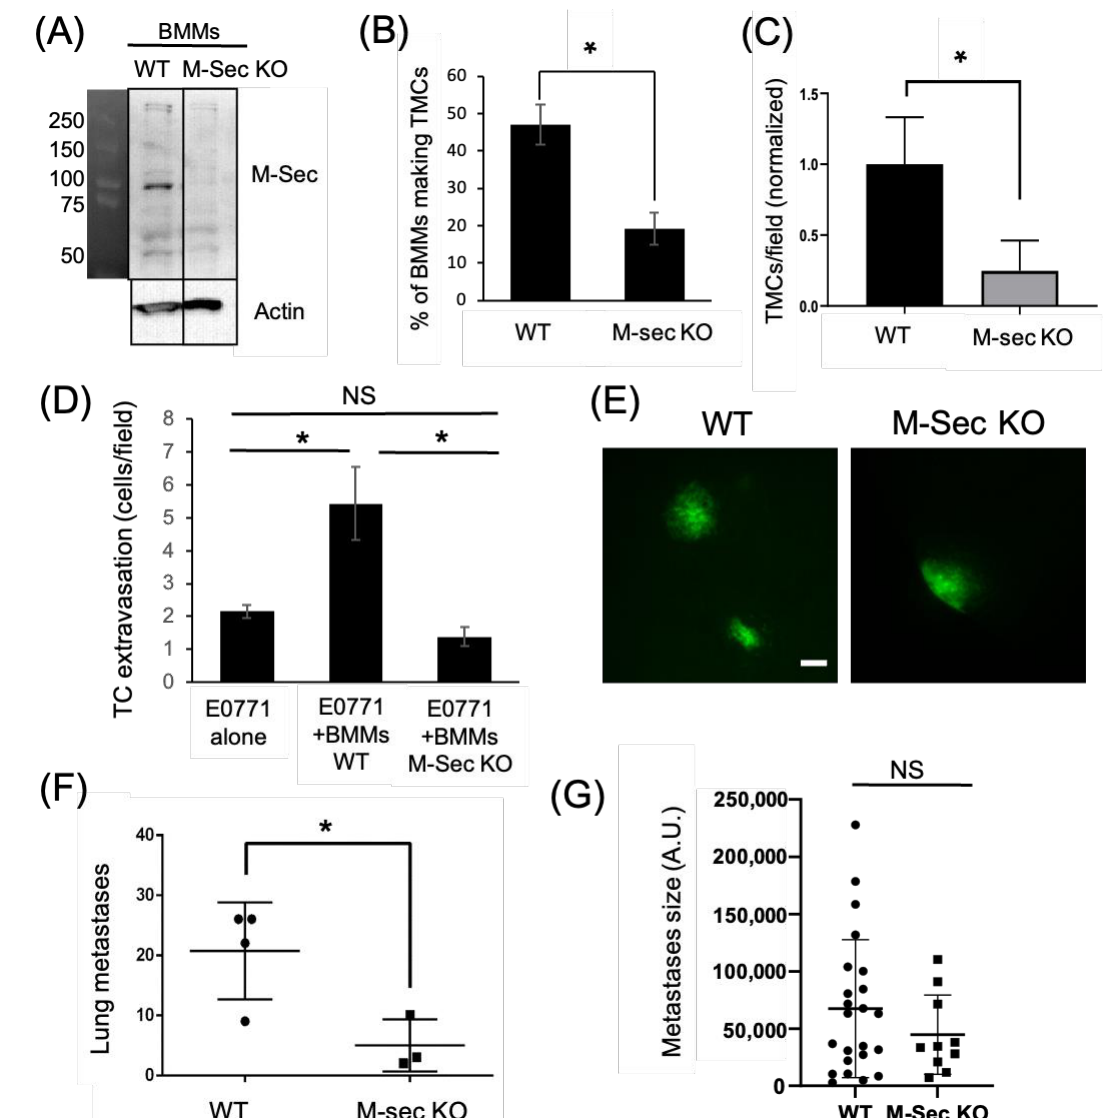
Figure 4. Tumor cell extravasation is impaired in vitro and in vivo by macrophages lacking the ability to form TMCs. ( A ) Western Blot showing M-Sec level in bone marrow derived macrophages (BMMs) isolated from either WT or M-Sec KO mice. Uncropped blot is shown in Figure S1. ( B ) WT or M-Sec KO BMMs were cultured overnight on a 35 mm MatTek TM dish and the percentage of BMMs making TMCs between macrophages and tumor cells determined. The results show a decreased ability of M-Sec KO BMMs to produce TMCs in vitro. ( C ) Quantification of TMCs formed between MDA-MB-231 cells and either WT or M-Sec KO BMMs across the endothelium 2 h after tumor cell introduction to the eTEM assay (N = 3 experiments) shows a reduction in the TMCs formed in vitro in the eTEM assay. ( D ) Quantification of GFP-E0771 tumor cells (TC) crossing the endothelium in the absence or presence of wild type (BMMs WT) or M-Sec deficient (BMMs KO M-Sec) in the eTEM assay. N = 3 experiments, 36 fields per experiment for each condition where analyzed. The results show that BMMs defective in forming TMCs impacted tumor cells extravasation. ( E ) Representative images of lung metastases derived from GFP-E0771 cells injected in the tail vein of either WT or M-Sec KO mice 7 days after tumor cell injection, scale-bar 100 µ m. Widefield images can be found in Figure S2. ( F ) Quantification of total number of metastases in either WT or M-Sec KO mice injected with E0771-GFP. (N = 4 for WT and N = 3 for M-Sec KO). ( G ) Quantification of metastasis size, per field. (N = 4 for WT and N = 3 for M-Sec KO). For all—* p < 0.05, NS =